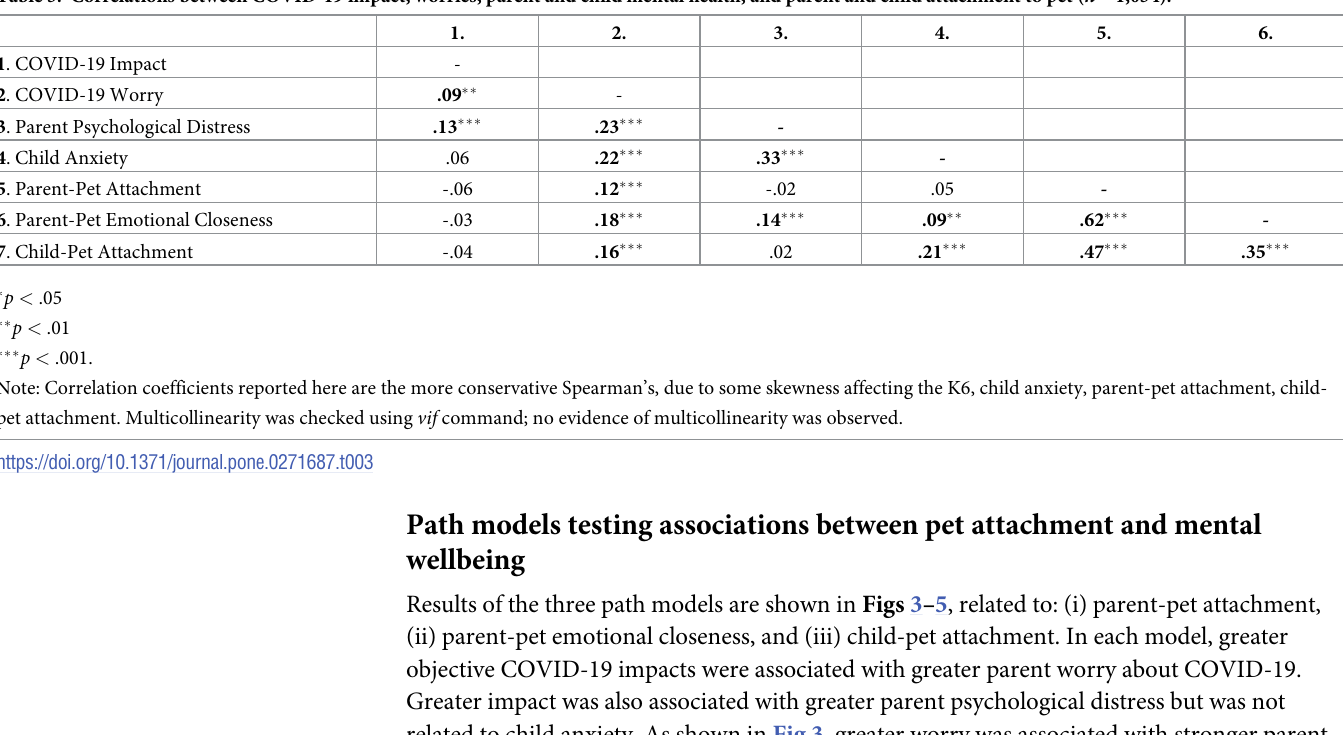
Table 3. Correlations between COVID-19 impact, worries, parent and child mental health, and parent and child attachment to pet ( n =